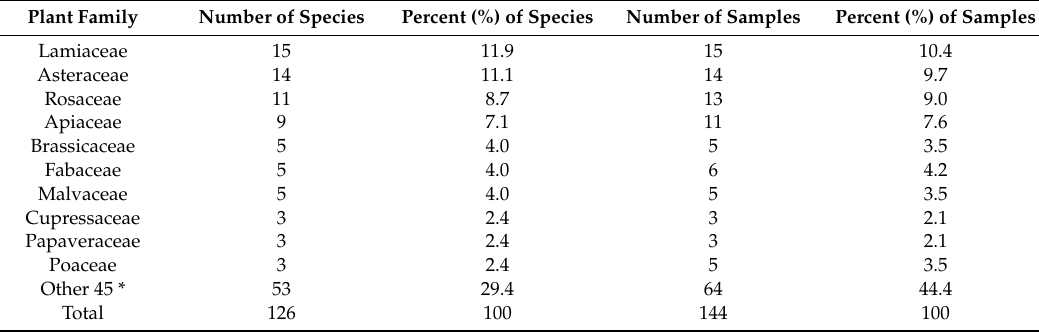
Table 2. Taxonomic diversity of the evaluated species collected from